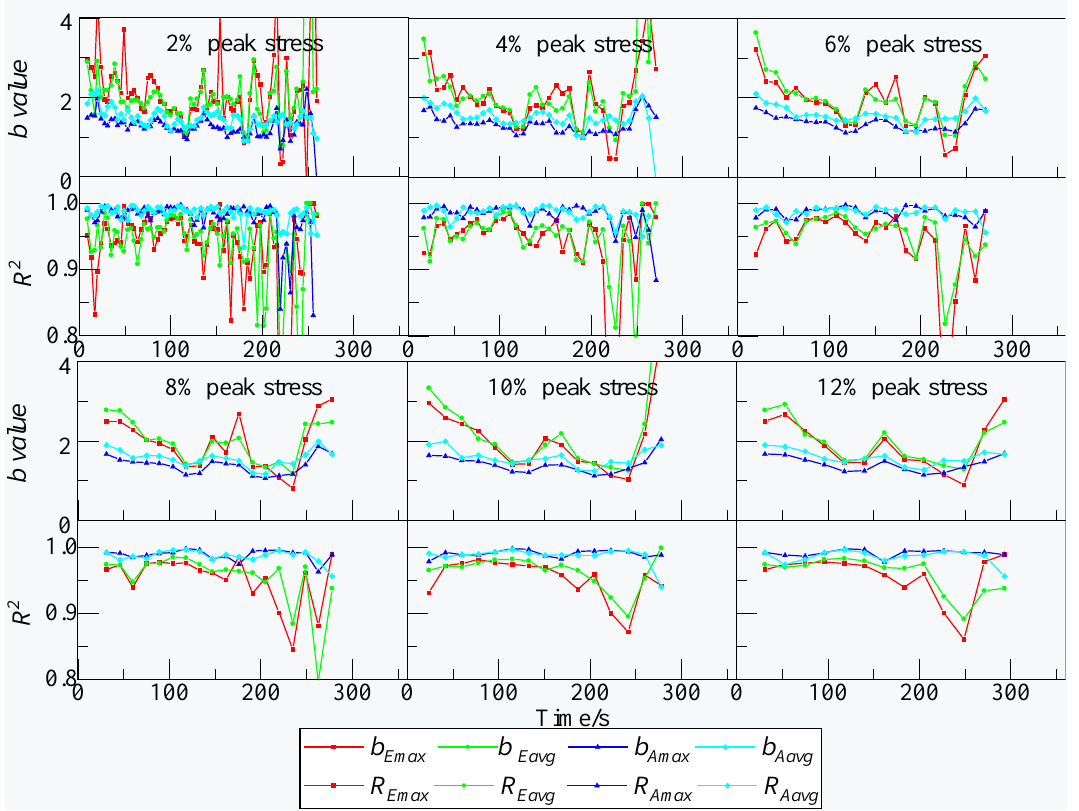
Figure 8. b value and its fitting goodness at different stress proportion intervals for the specimen G-10-10. The range of b Amax values is between 0 to 2.21. Table 3. The mean of R 2 at different AE stress proportion intervals for the specimen